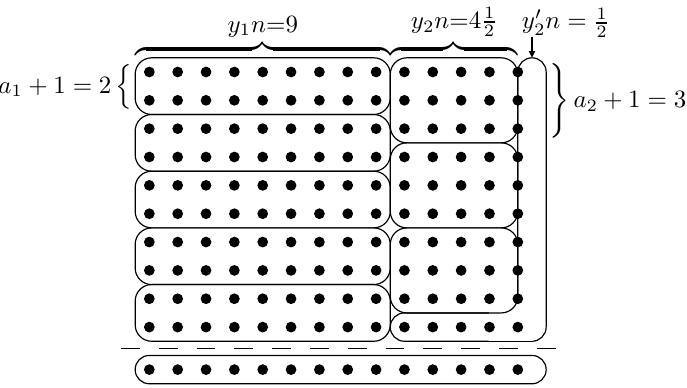
Figure 10: Graphical representation of an ideal ∆(9 , 10) -colouring of K